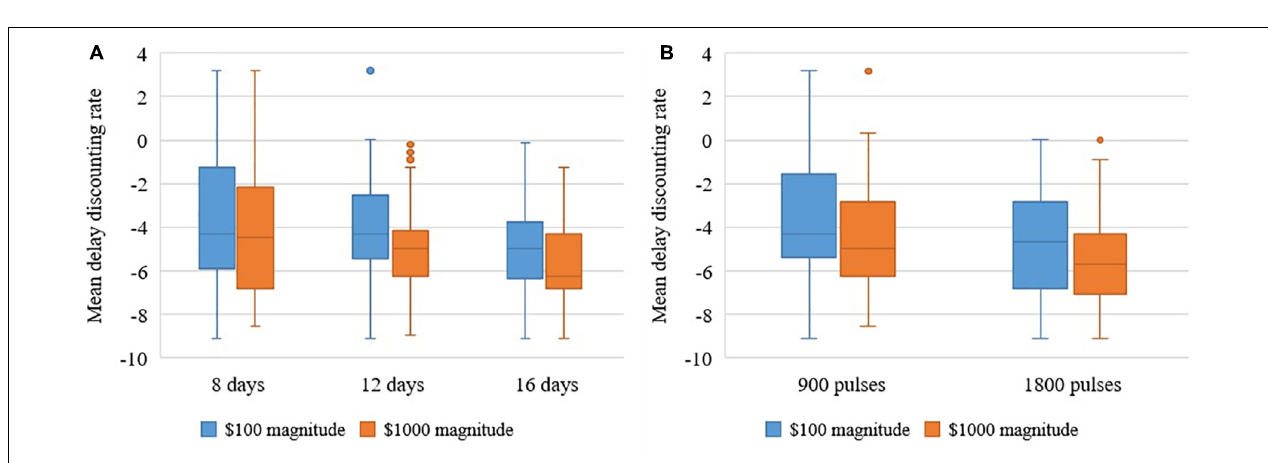
FIGURE 1 | Probability of abstinence over 6 months by duration and intensity of repetitive transcranial magnetic stimulation.